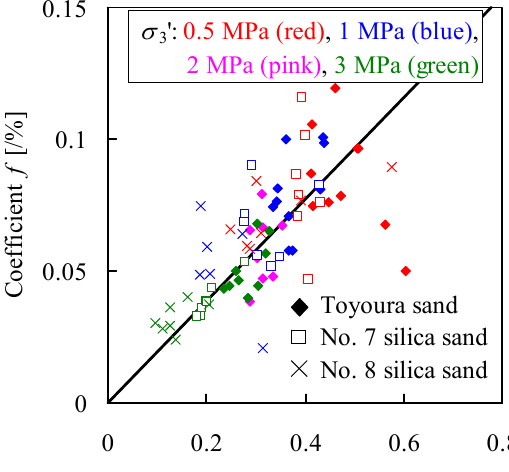
Figure 12. Coefficient f versus initial tangent Poisson’s ratio υ using Equation